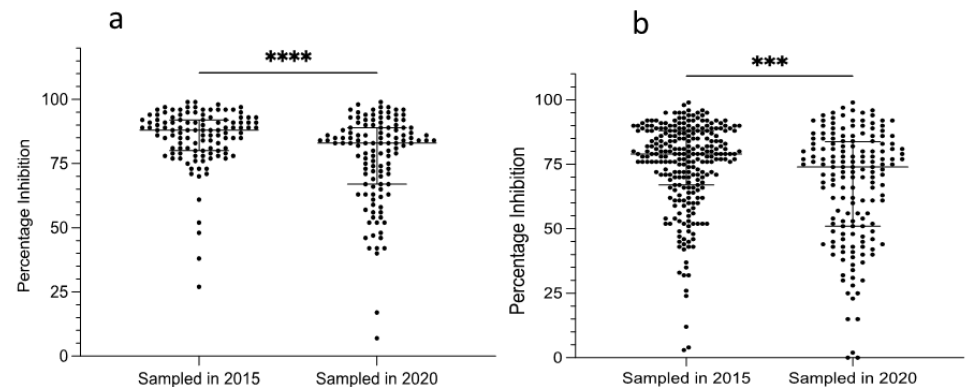
Figure 5. Comparison of PC-ELISA percentage inhibition (PI) values for sera of camels sampled before (2015) and after (2020) the first report of heartwater-like disease in camels in Kenya; ( a ) cam- els sampled in areas where the disease was reported; ( b ) camels sampled in areas where the disease was not reported. In both groups, median PI (widest horizontal line) was significantly lower in 2020 than in 2015. Data were analysed in a two-tailed Mann – Whitney test; *** p = 0.0002, **** p < 0.0001.